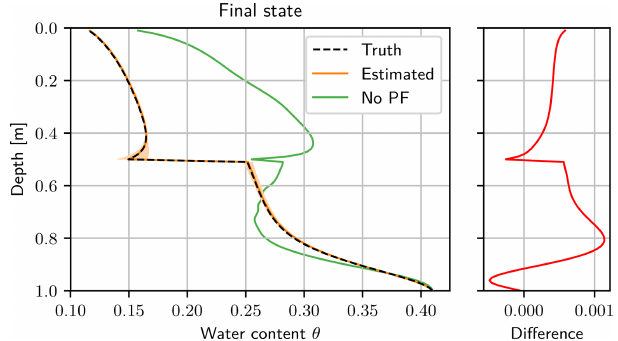
Figure 7. Final water content state after the assimilation run. The truth (black dashed line) is almost congruent with the estimated mean (orange line), so only the 95% quantile of the ensemble (light orange) is visible. The final ensemble with the correspond- ing weights is used to start a free forward run afterwards. The mean without data assimilation (green line) is calculated from a forecast of the initial ensemble (see Figs. 4 and 6). The difference of the es- timated water content and the synthetic truth lies in a narrow band, with a small bias towards larger water contents.